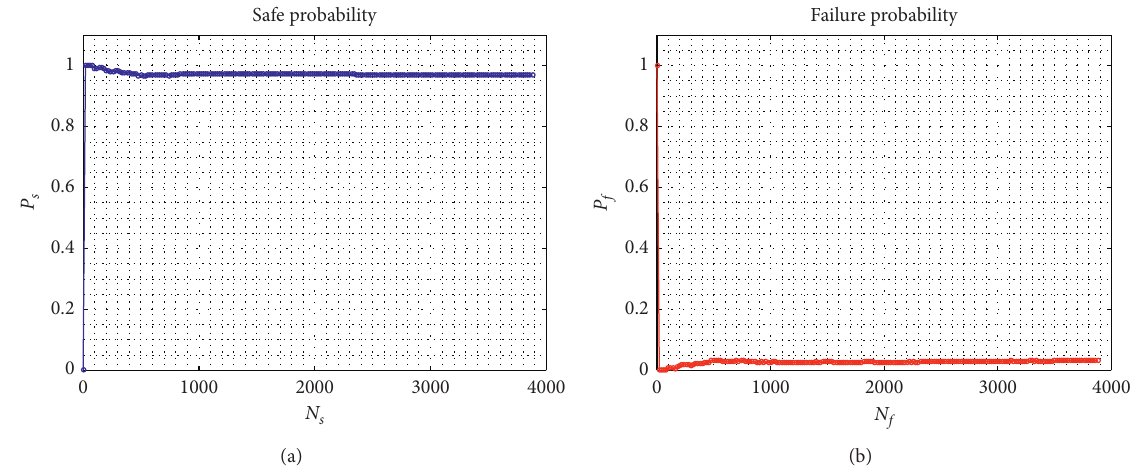
Figure 10: Convergence of the safe probability of the 10-year corroded SCC